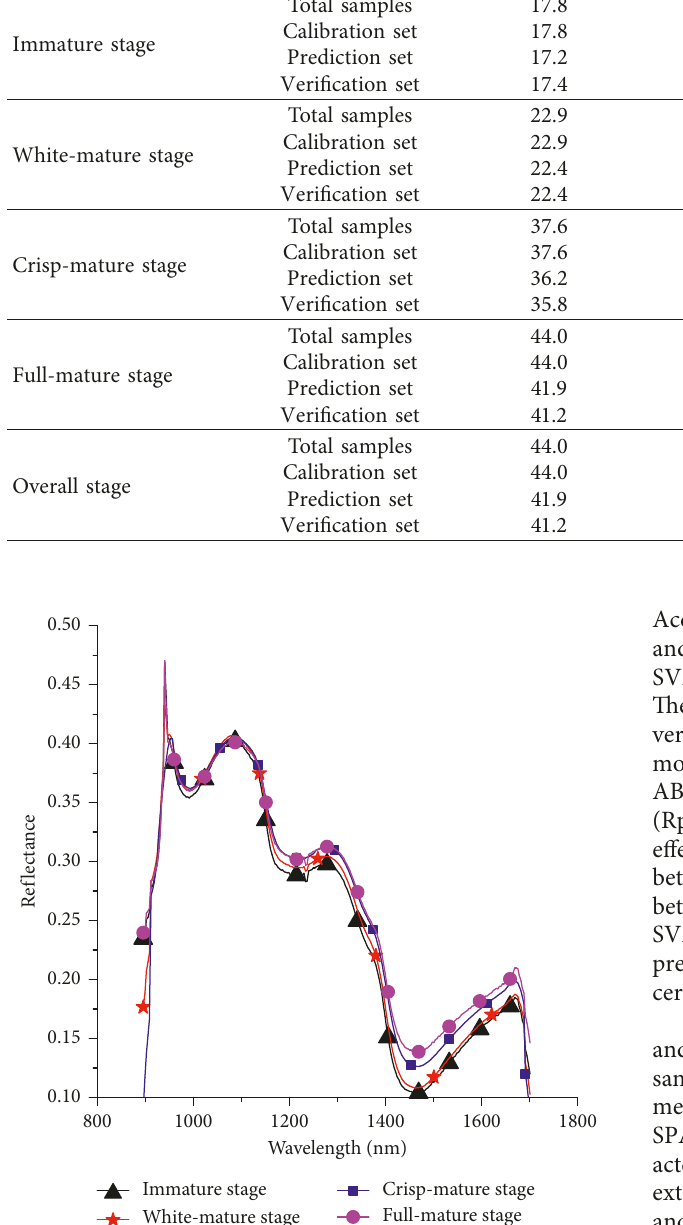
blue (low value) to red (high value). The color of the im- are shown in yellow, which indicated that the SSC was low.